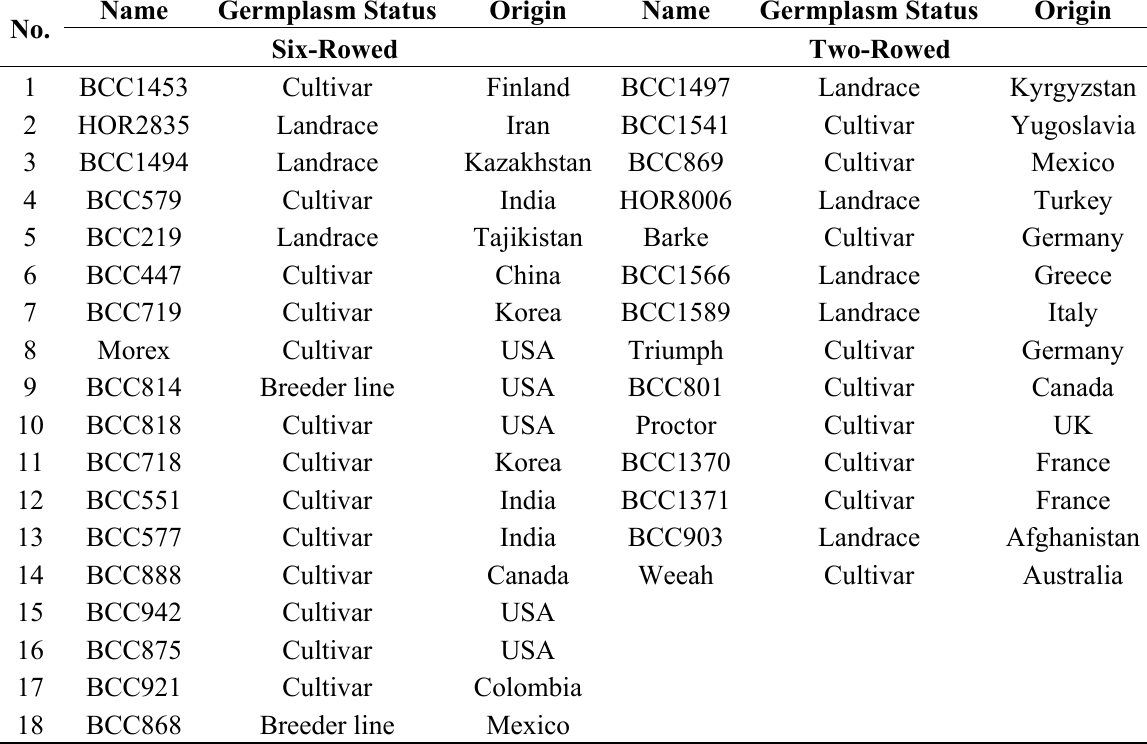
Table 4. Spring barley accessions according to row-type, name, germplasm status, and origin.